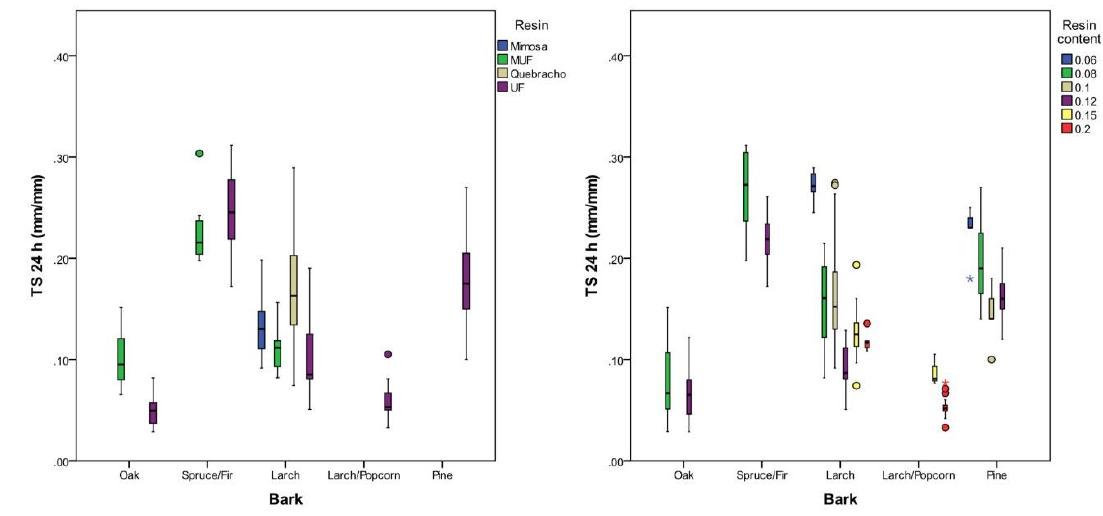
Figure 6. TS after 24 h of water immersion according to bark type, resin content and type. Table 7. TS after 24 h of water soaking.